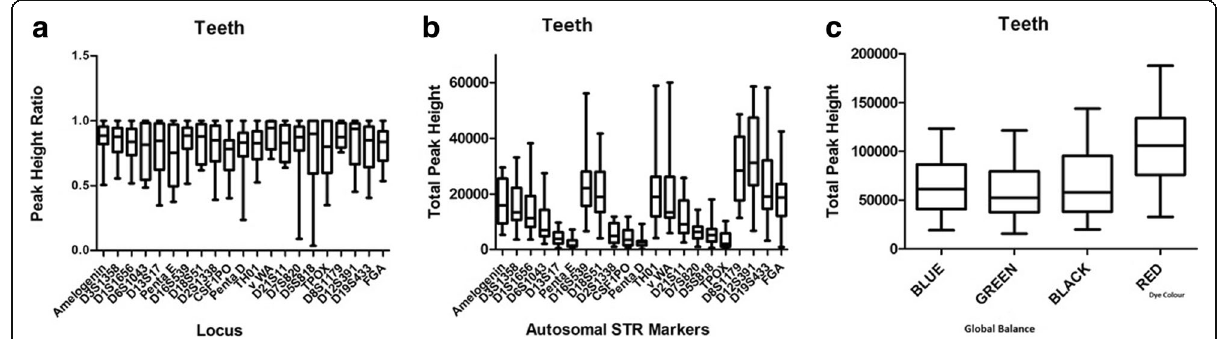
Fig. 6 Profile quality parameters for teeth samples. a Peak height ratio. b Total peak height. c Global